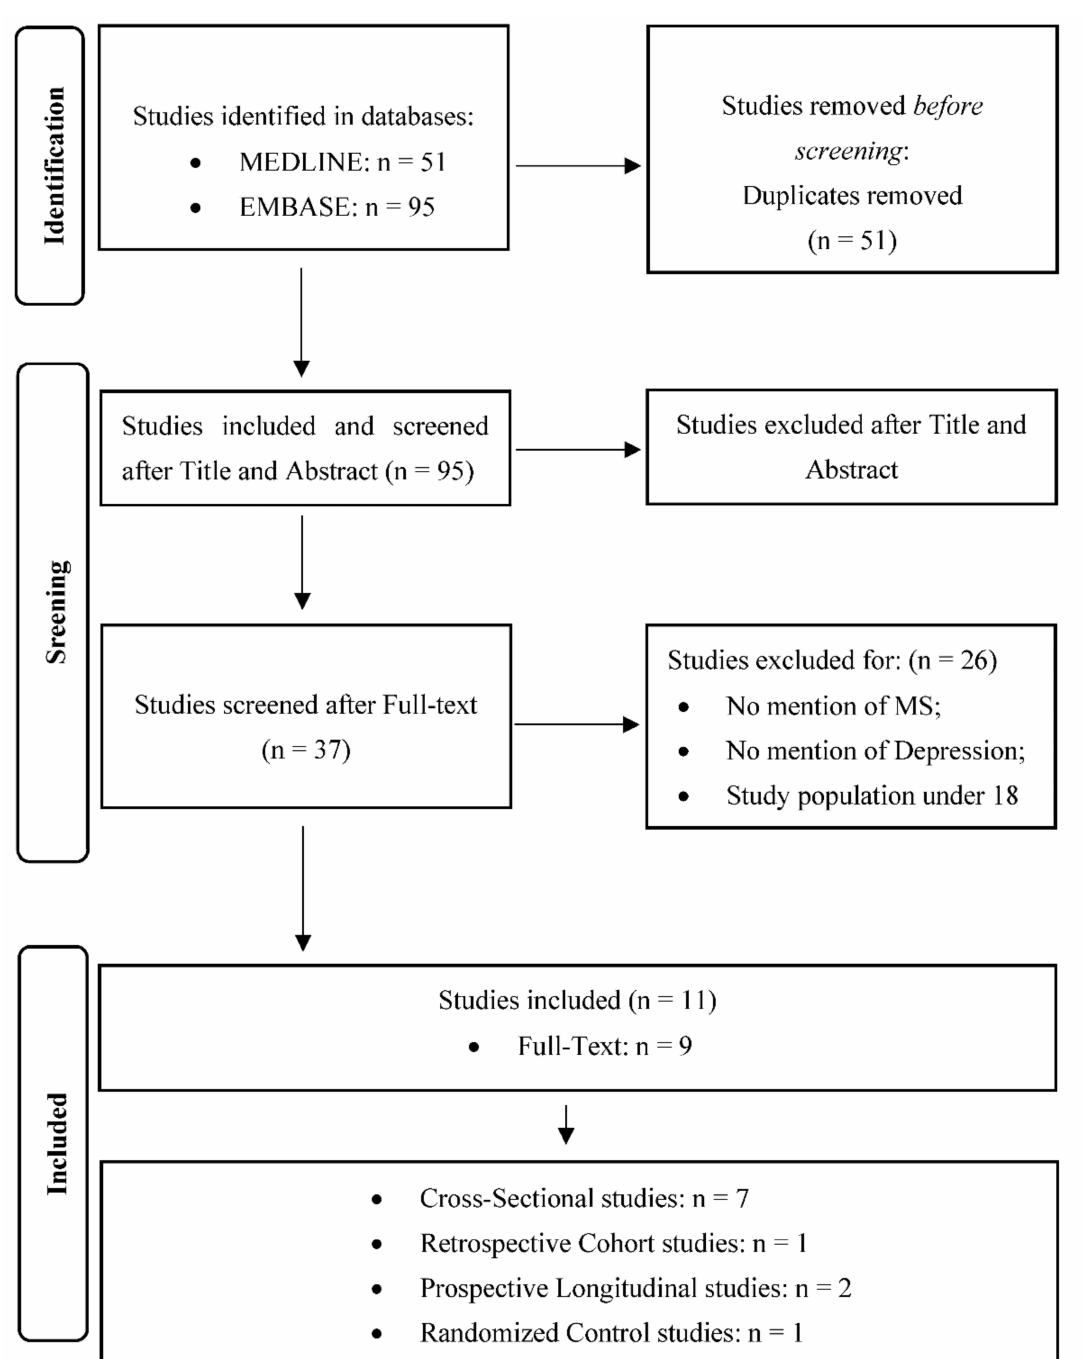
Figure 1. PRISMA